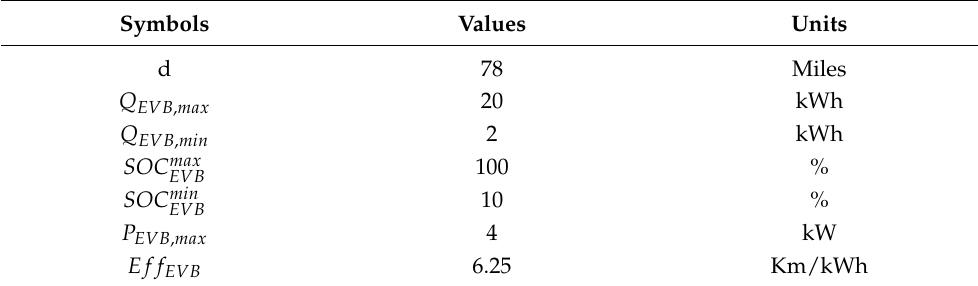
Table 5. EV Battery System Parameters.